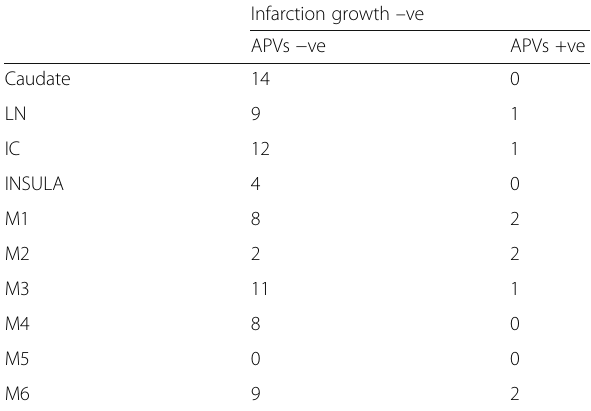
Table 3 Distribution of APVs in the acutely infarcted MCA territories in all